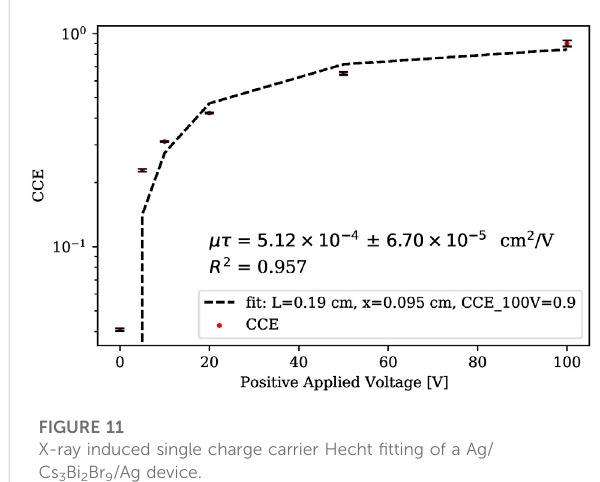
FIGURE 10 X-ray induced response (X-ray tube at 50 kV and 140 mA) under varied applied bias voltage of a Ag/Cs 3 Bi 2 Br 9 /Ag device.